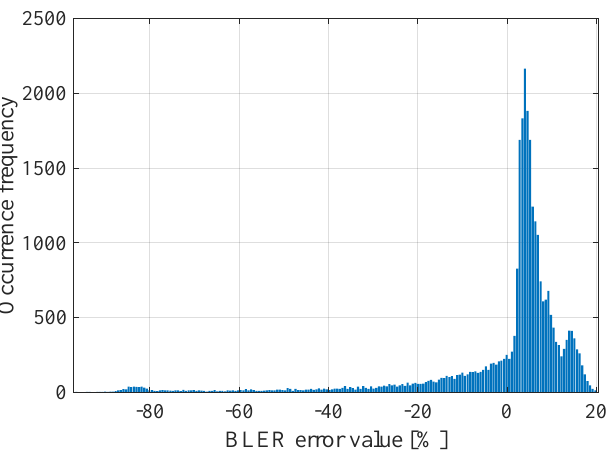
Figure 5. The histogram of the estimated BLER metric prediction errors for prediction using the 15th-order FIR filter.